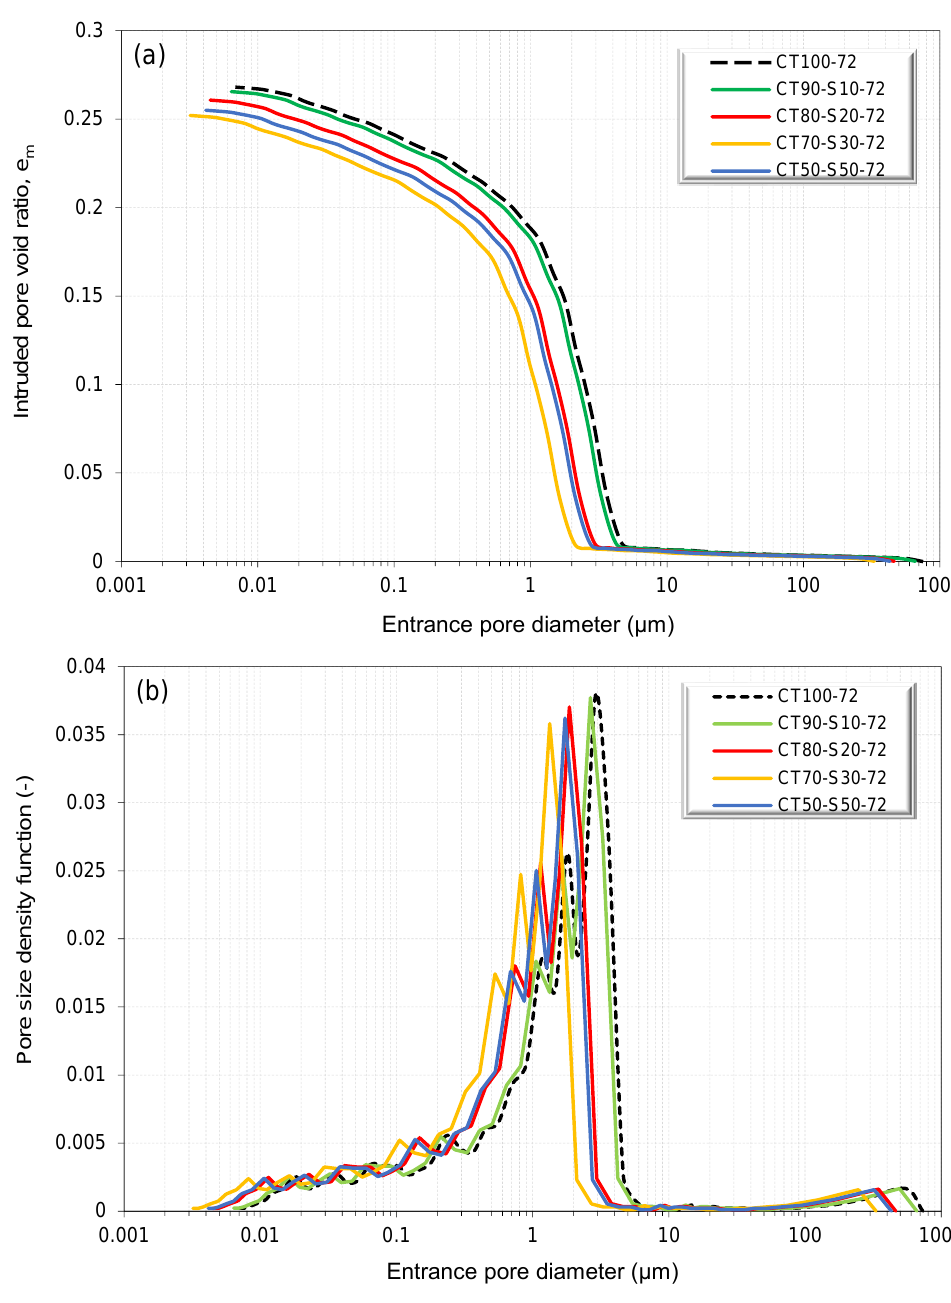
Figure 5. MIP results of 72 wt.% solid fill specimens: ( a ) cumulative; ( b ) incremental curves.